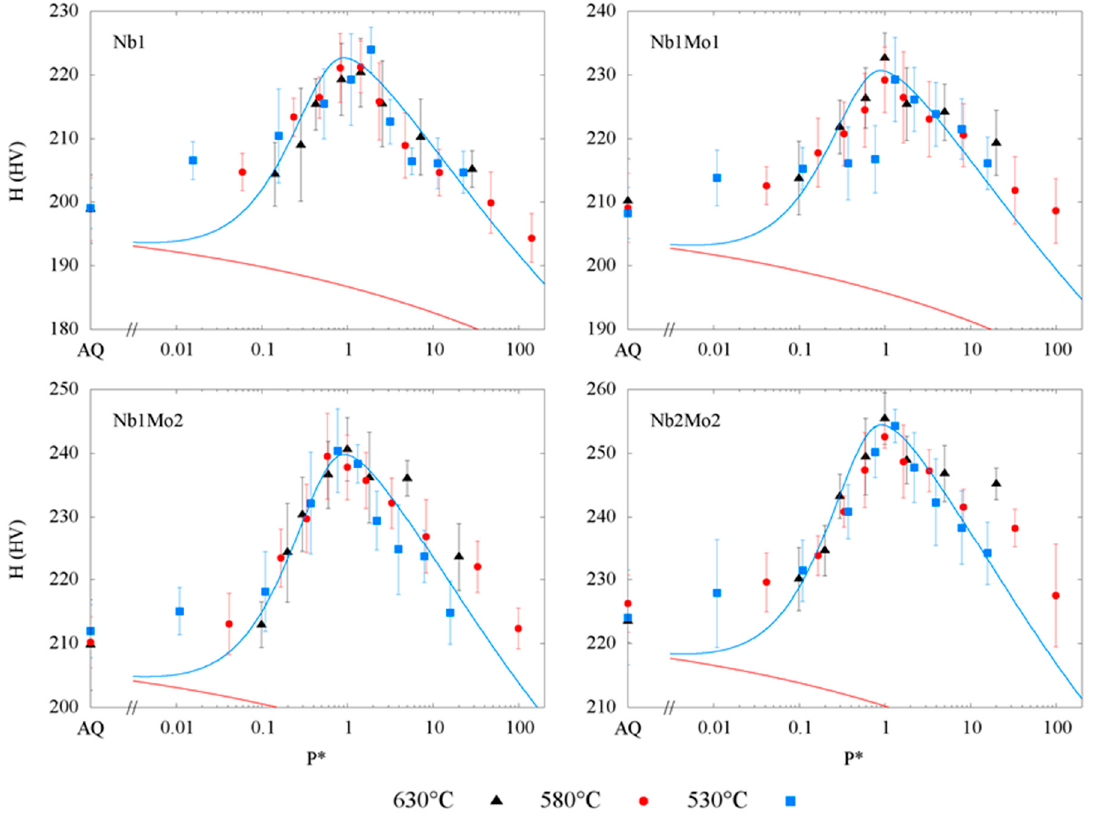
Figure 14. Comparison of modelled and measured hardness for the four investigated steels, Nb1, Nb1Mo1, Nb1Mo2 and Nb2Mo2, at the three aging temperatures. The red curve represents the microstructure softening and the blue curve is obtained by adding the precipitation strengthening contribution.